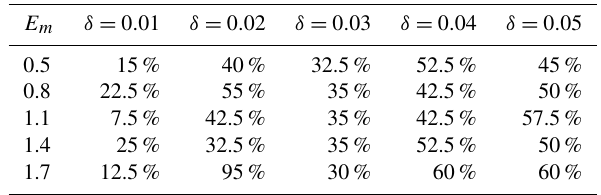
Table 8. The LBMPT estimated by the PSO-CNOP method.